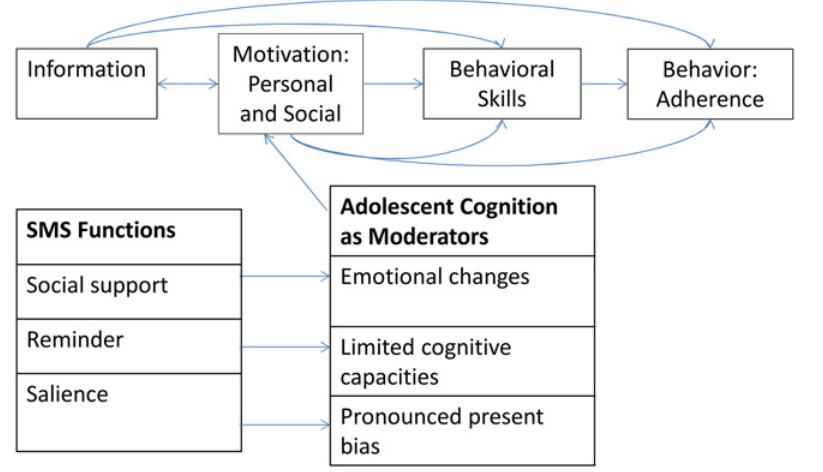
Fig 1. IMB model adapted to RATA